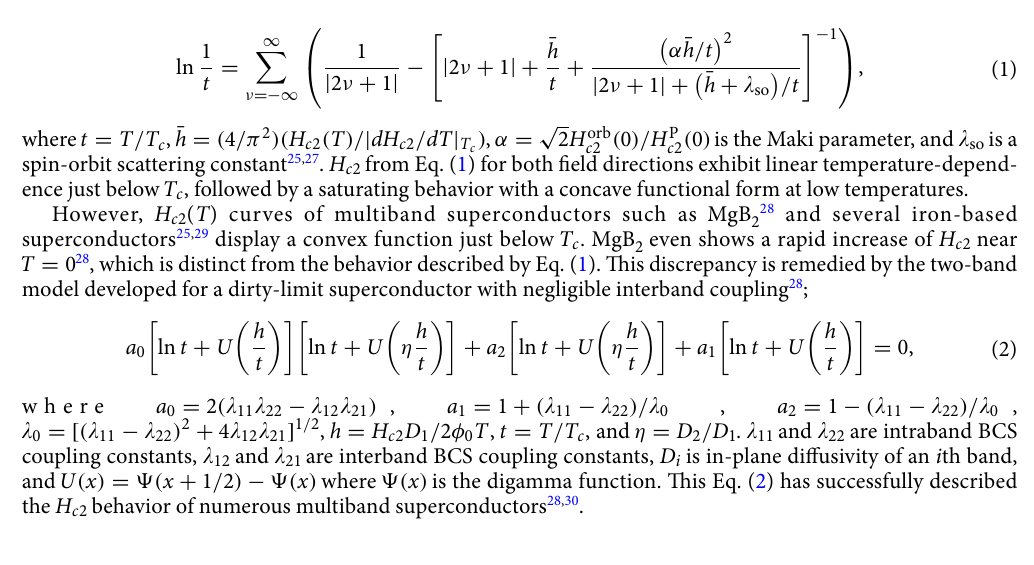
Figure 2. ( a ) Temperature dependence of in-plane resistivity ρ of the 2H-Pd 0.08 TaSe 2 single crystal at zero magnetic field. The ρ starts to decrease ( T on c ) at 3.3 K and goes to zero ( T 0 c ) at 3 K. The inset shows the resistivity data below 30 K and a power law fitting (red dashed line) with ρ 0.149 m (cid:31) cm . ( b ) Magnetic susceptibilities measured at H = 10 Oe applied parallel to the ab -plane in both zero field cooled (ZFC) and field cooled (FC) conditions. At 1.9 K, 4 πχ is about 93%, showing nearly full Meissner